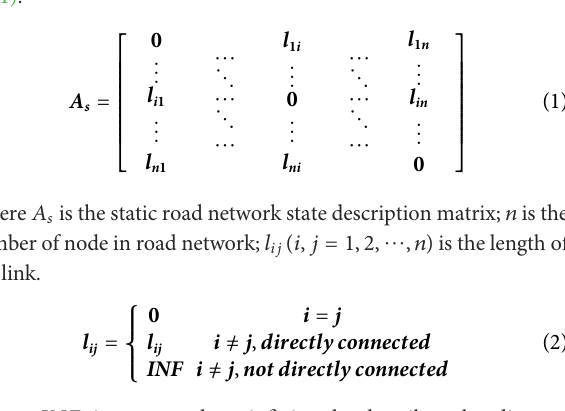
FIGURE 1 Calculation fl ow chart of charging